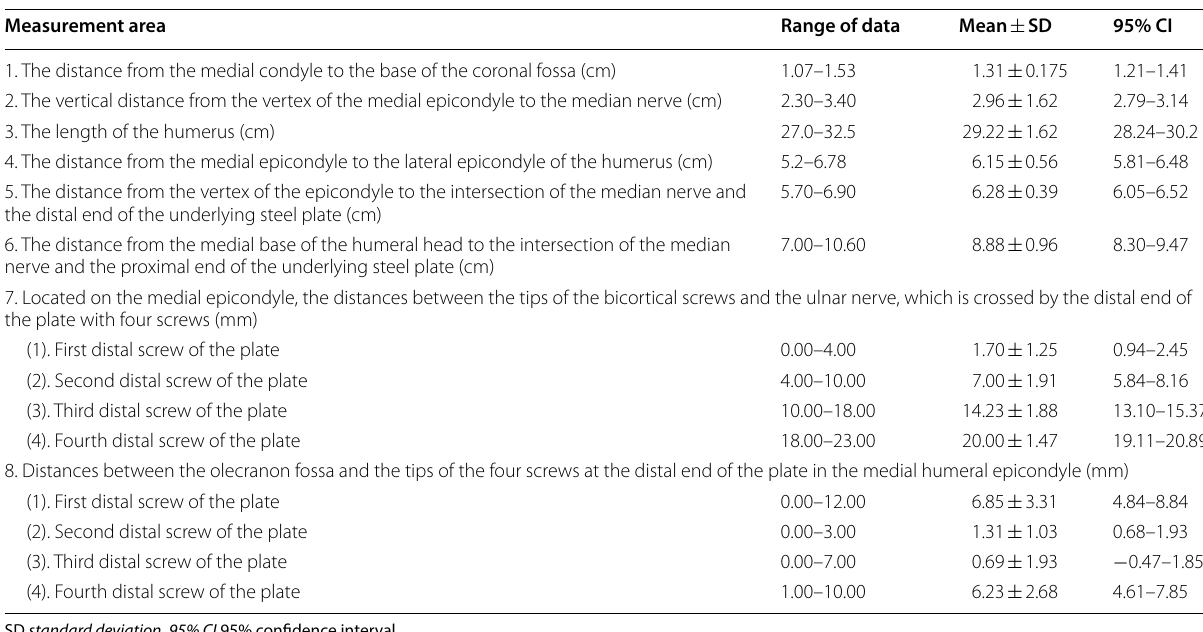
Table 5 Analysis of measurement